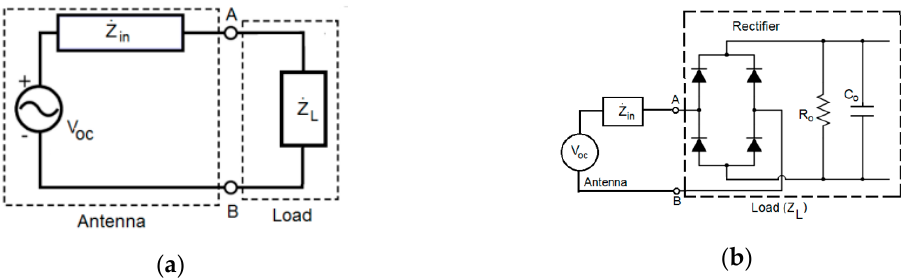
Figure 7. The equivalent circuitry of the antenna connected directly to the rectifier: ( a ) the equivalent loop circuit and ( b ) the details of the full wave rectifier with the resistance R o and the smoothing capacitor C o at its output.